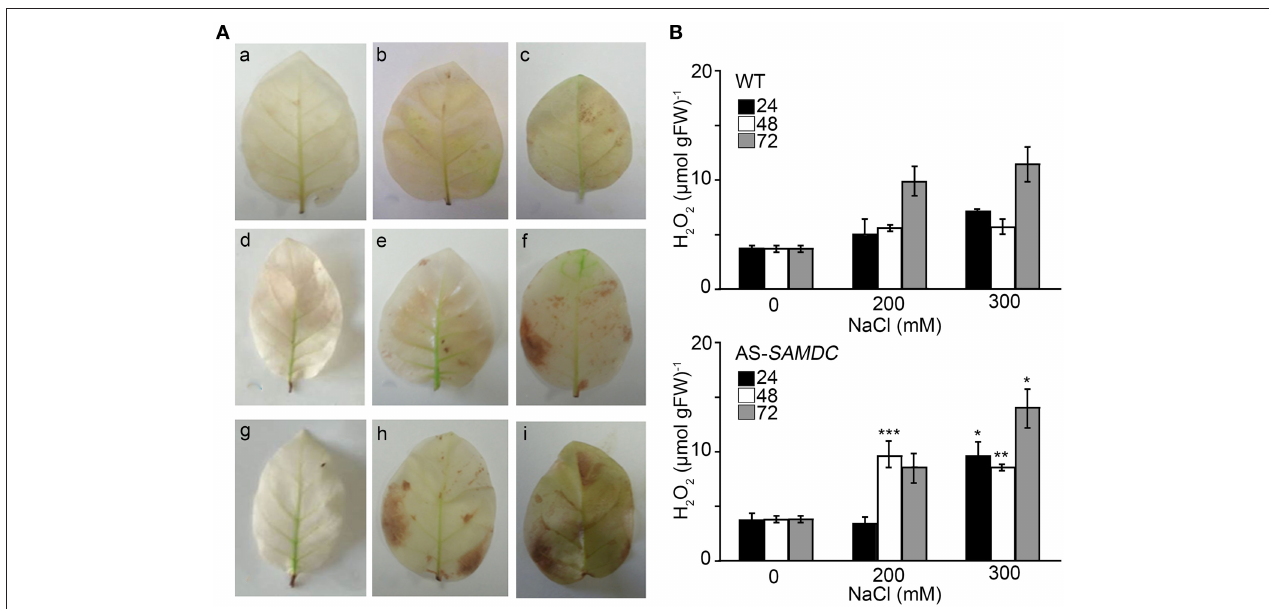
FIGURE 8 | Levels of Hydrogen peroxide in WT and AS- SAMDC leaves under control and NaCl treatment. (A) In situ detection of H 2 O 2 leaves of WT and AS- SAMDC plants after exposure to 200 and 300mM NaCl; 24h (a–c), 48h (d–f), and 72h (g–i), control (a,d,g); 200mM NaCl (b,e,h); 300mM NaCl (c,f,i). Images are from a single representative experiment replicated three times. (B) Hydrogen peroxide levels in WT and AS- SAMDC control plants. Data are means ± SD of three biological replicates. Asterisks indicate significant difference of mean values of AS- SAMDC from WT (Student’s t -test; * P < 0.05, ** P < 0.01, and *** P < 0.001).